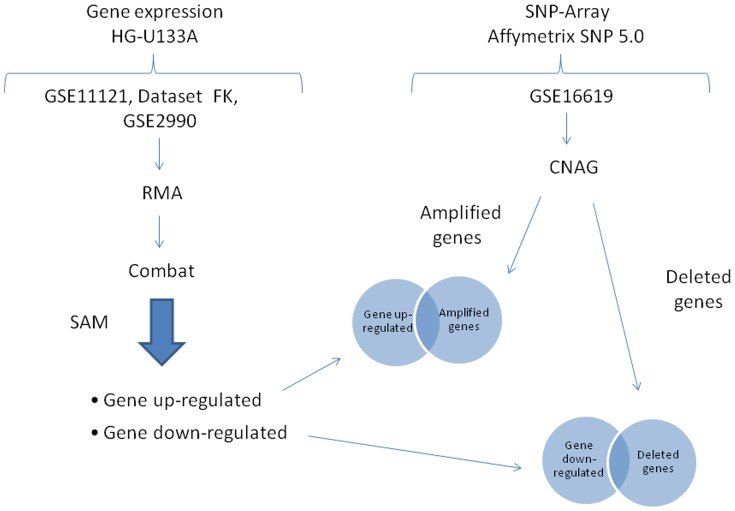
Schematic procedure Gene Expression and Genome CNA.Identification of up regulated genes with copy number gains and down regulated genes with copy number losses is showed.